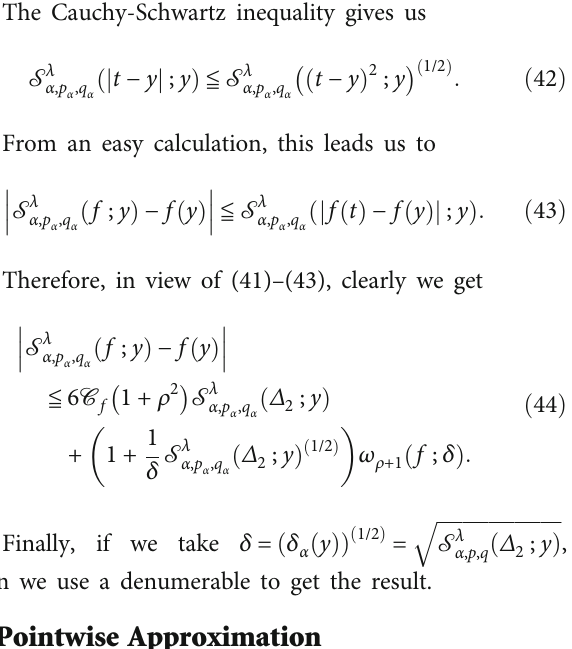
ffiffiffiffiffiffiffiffiffiffiffi δ α y ð Þ